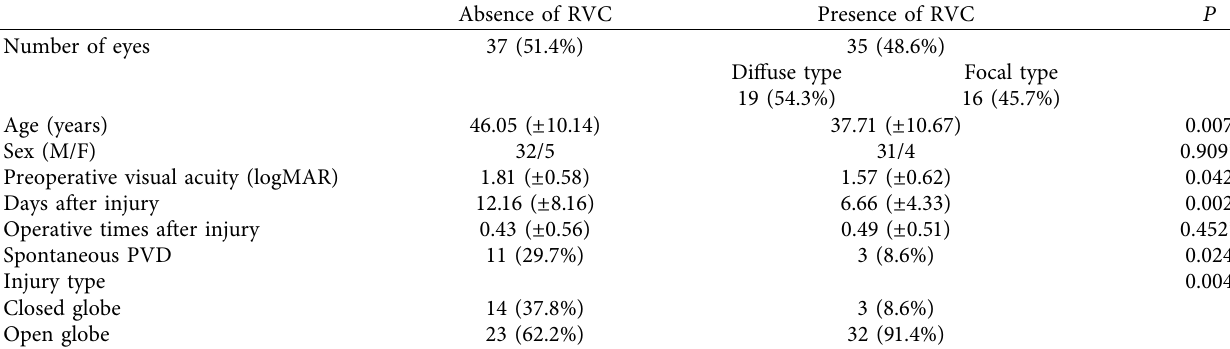
Table 1: Clinical characteristics of ocular trauma patients with absence and presence of